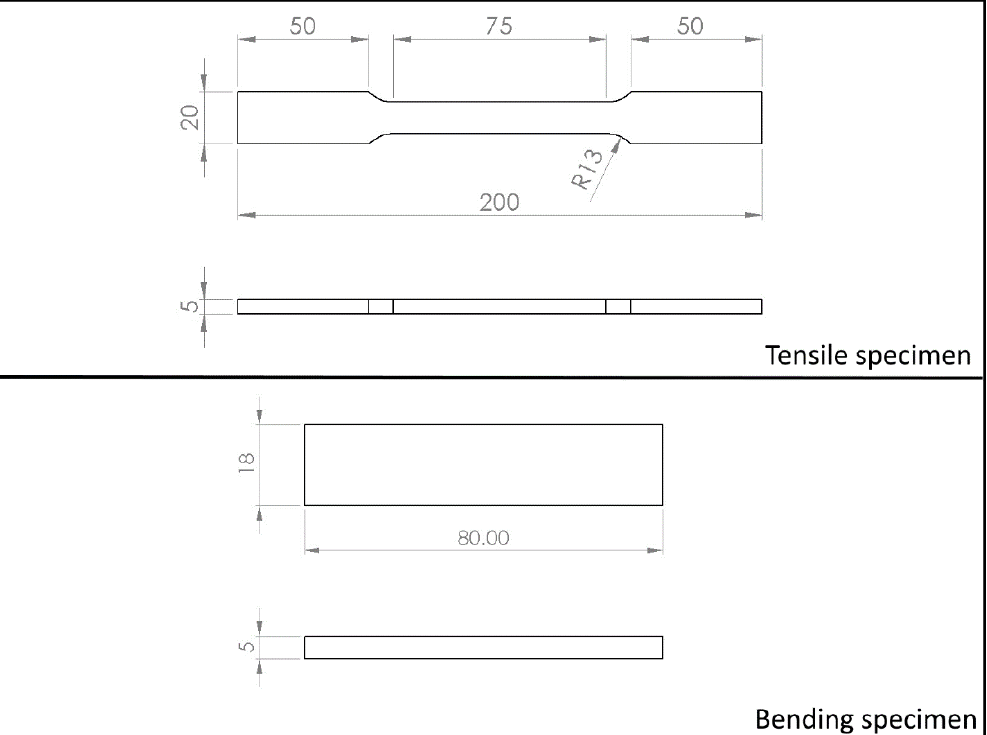
Figure 1. Schematics showing the actual size of tensile and bending specimens used within this research work.